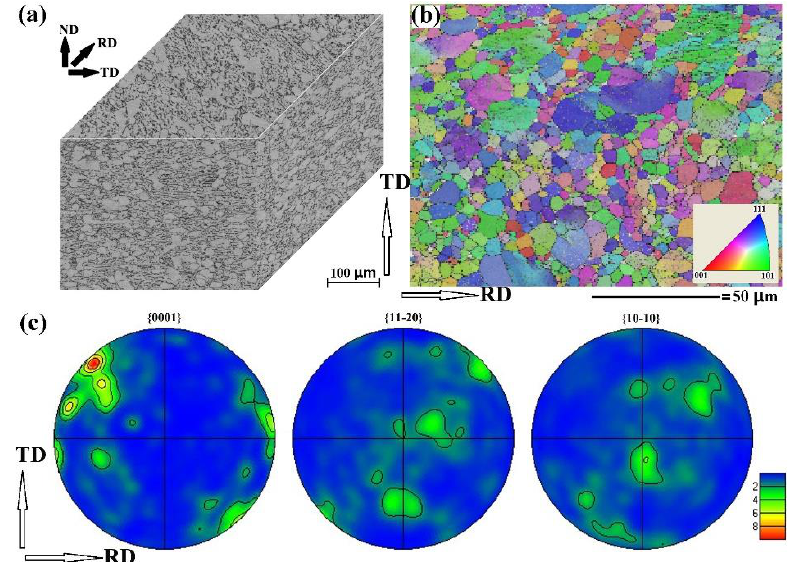
Figure 1. Initial microstructure of the mill-annealed TC4 alloy plate. ( a ) Optical micrographs recorded in the RD–TD plane, RD–ND plane and TD–ND plane of the plate; ( b ) orientation imaging microscopy (OIM) micrograph for α phase in the RD–TD plane; ( c ) α -{0001}, α -{11-20} and α -{10-10} pole figure of ( b ).